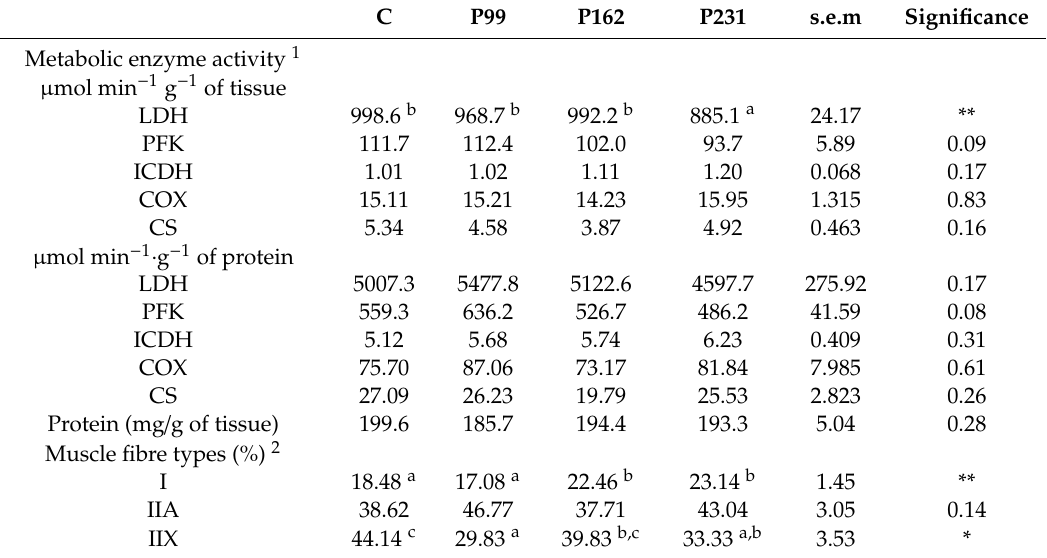
Table 4. Metabolic enzyme activity and fibre type characteristics of longissimus thoracis muscle from bulls raised on either a concentrate-based system (C) or pasture-based systems incorporating 99 days (P99), 162 days (P162) or 231 days (P231) grazing prior to indoor finishing on a concentrate-based